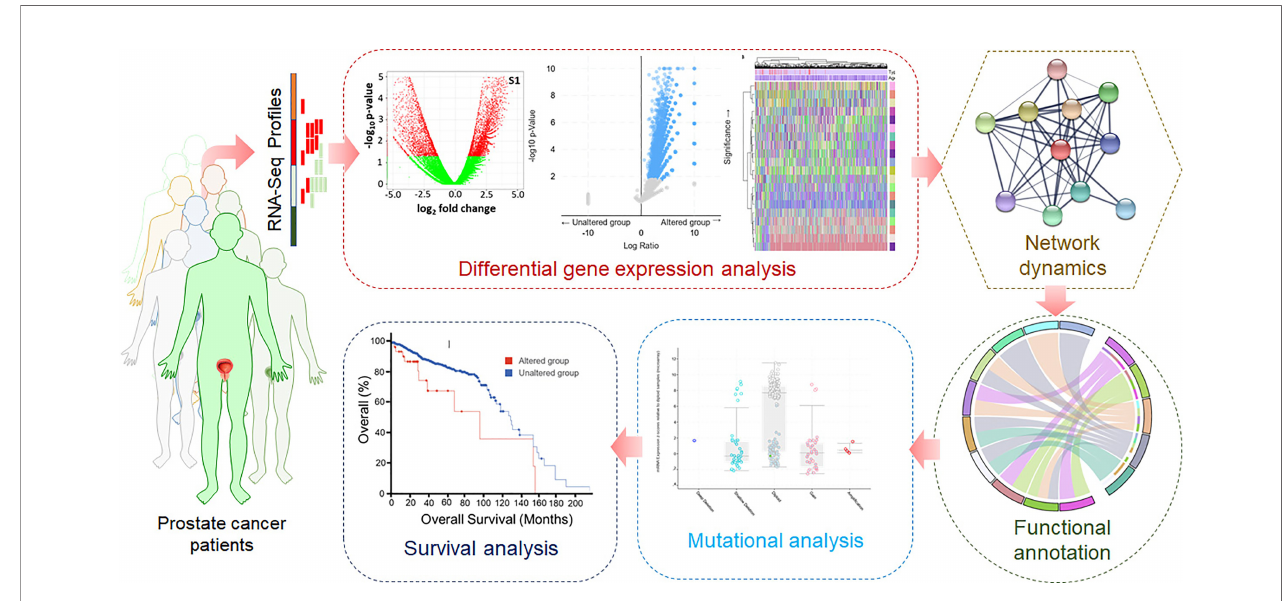
FIGURE 1 | Graphical fl owchart of the